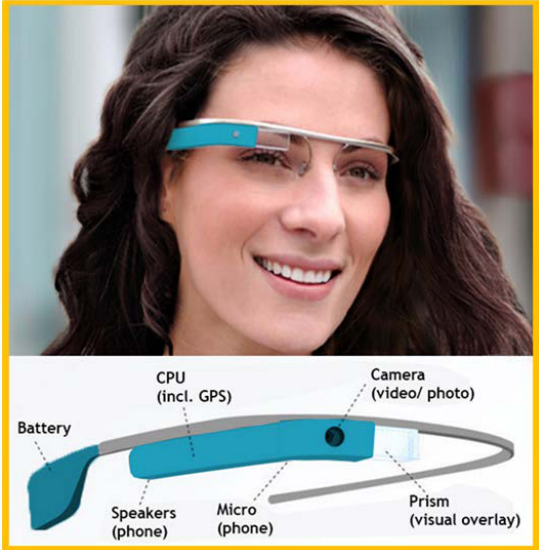
Figure 7. Google augmented reality enabled glass with voice com- mand capability